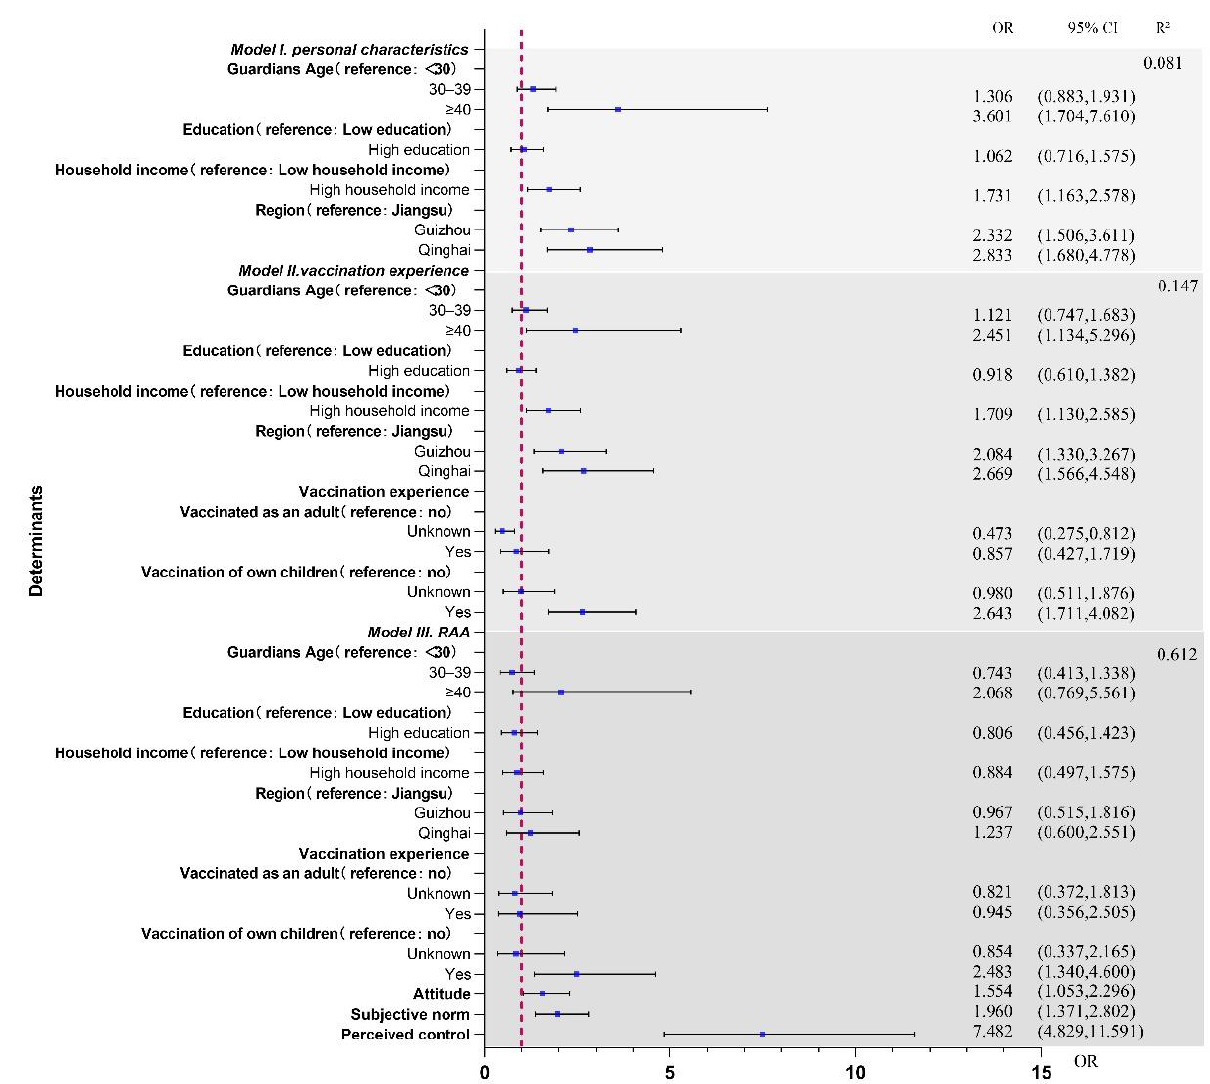
Figure 4. Hierarchical logistic regression analysis of the determinants of intention to accept pertussis cocooning vaccination among guardians. Abbreviations: OR, odds ratio; CI, confidence interval.